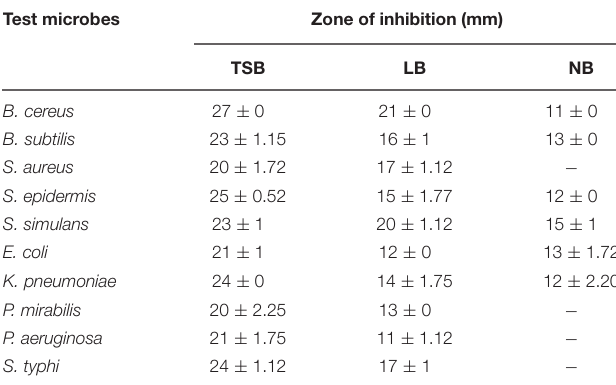
TABLE 2 | Antimicrobial activity of crude extract. Test microbes